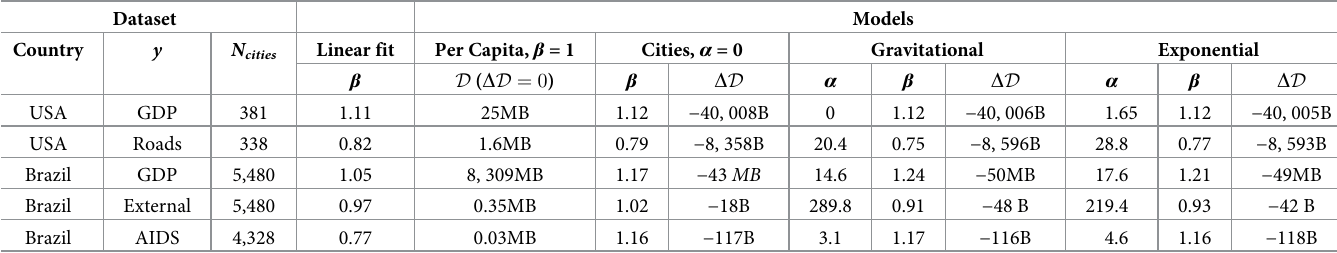
Table 2. Results of the four models in five databases.